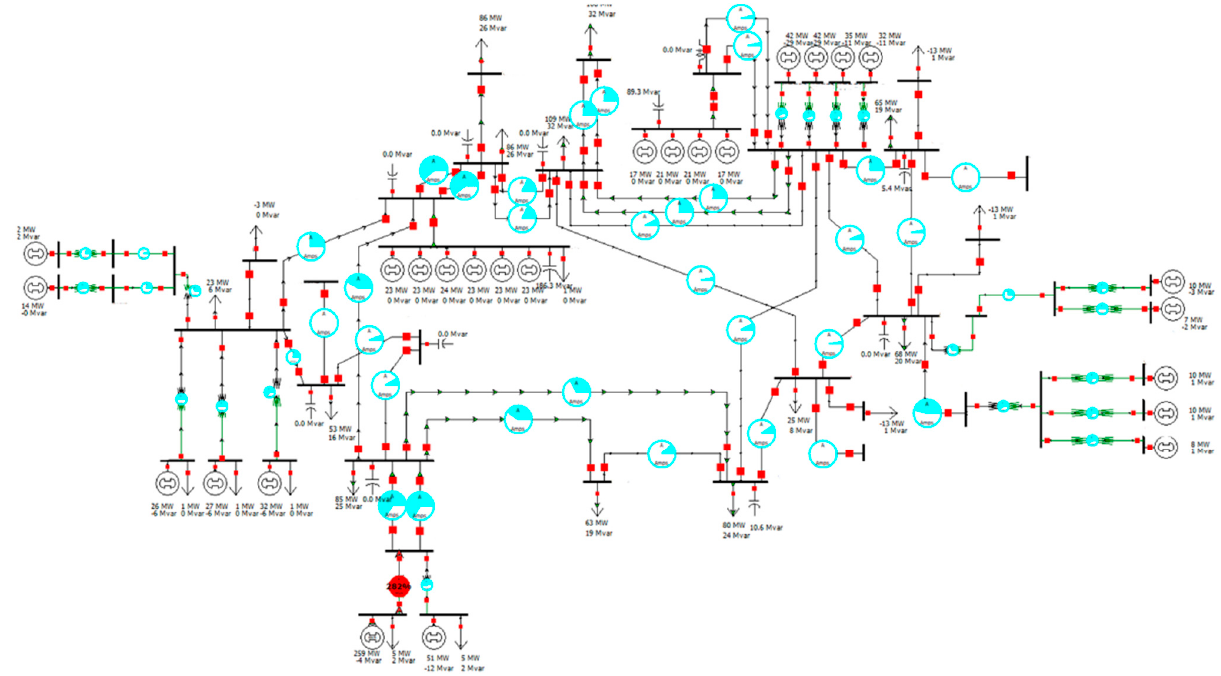
Figure 6. Systematic diagram with application of the proposed methodology.